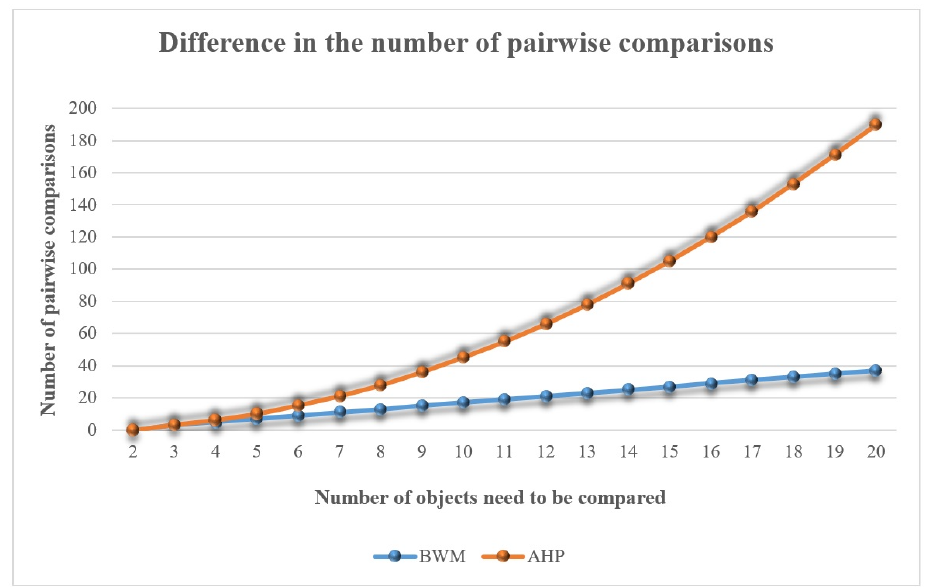
Figure 7. Differences in the number of pairwise comparisons needed by BWM and